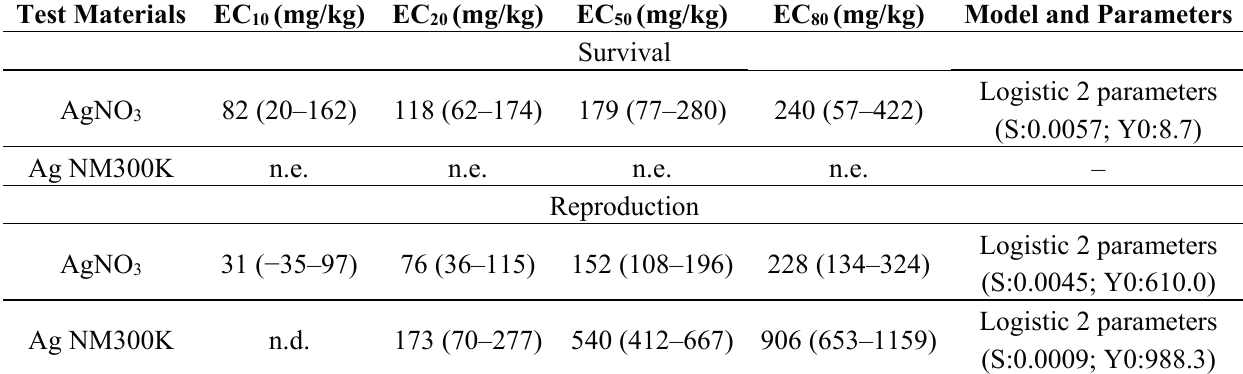
Figure 1. Survival (number of adults) and reproduction (number of juveniles) for Folsomia candida when exposed in LUFA 2.2 soil to ( A ) AgNO 3 and ( B ) Ag NM300K. Results are expressed as average ± standard error (Av ± SE) ( n = 4). * : Dunnett’s ( p < 0.05) for differences between control and treatments. Lines represent the model fit to data. Table 1. Effect Concentrations (ECx) for survival and reproduction of Folsomia candida when exposed to AgNO 3 and AgNPs (Ag NM300K). n.d.: not determined. n.e.: no effect (95% Confidence Intervals). EC 10 , 20 , 50 , 80 : Concentration that causes 10%, 20%, 50%, 80% Effect, respectively. S: relative slope estimated at EC 50 , Y0: Average control value (average of control values for survival and